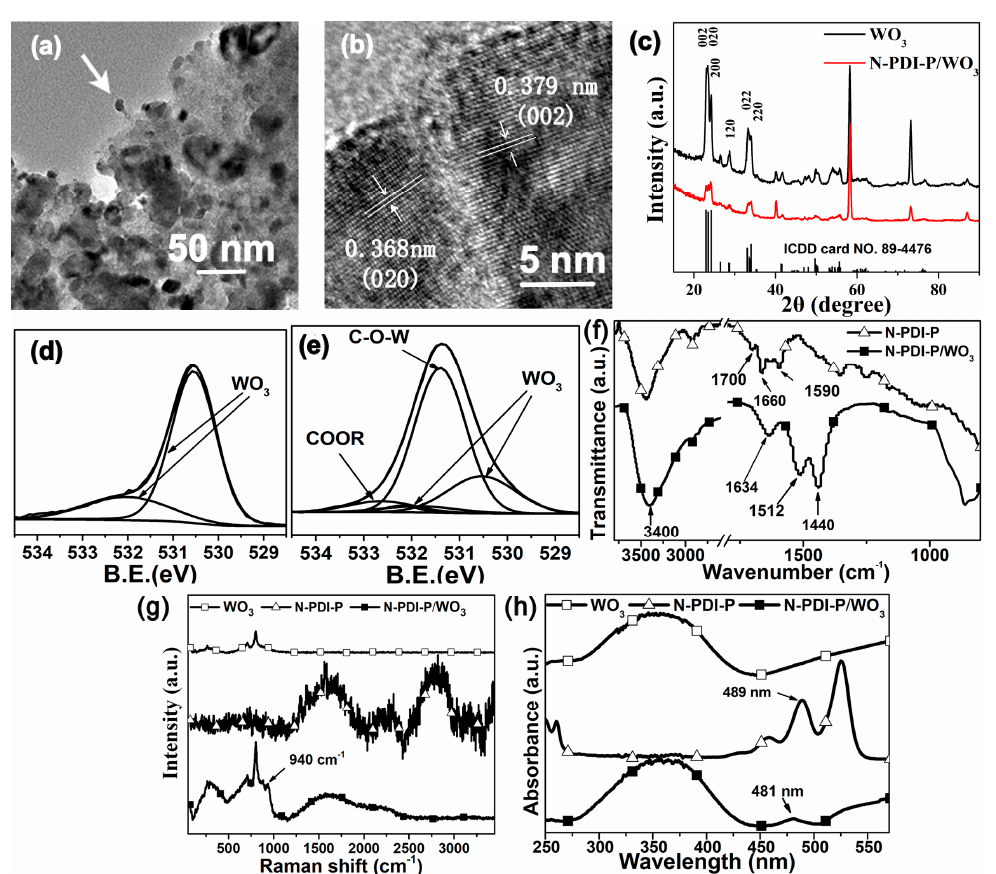
Figure 2. ( a , b ) TEM images and ( c ) XRD spectra of N-PDI-P / WO 3 after 1 d infiltration; the O 1s XPS spectra of ( d ) WO 3 and ( e ) N-PDI-P / WO 3 after 1 d infiltration; ( f ) Infrared spectroscopy, ( g )